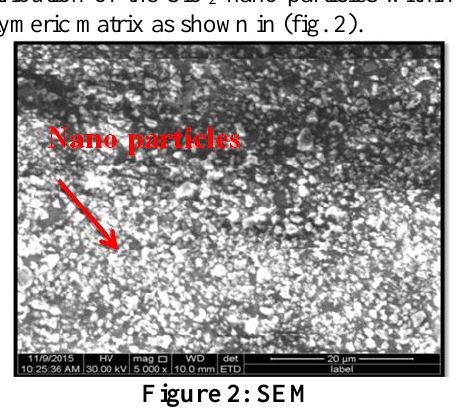
Table 1: Descriptive statistics, One-way ANOVA and LSD of Tear Strength Control